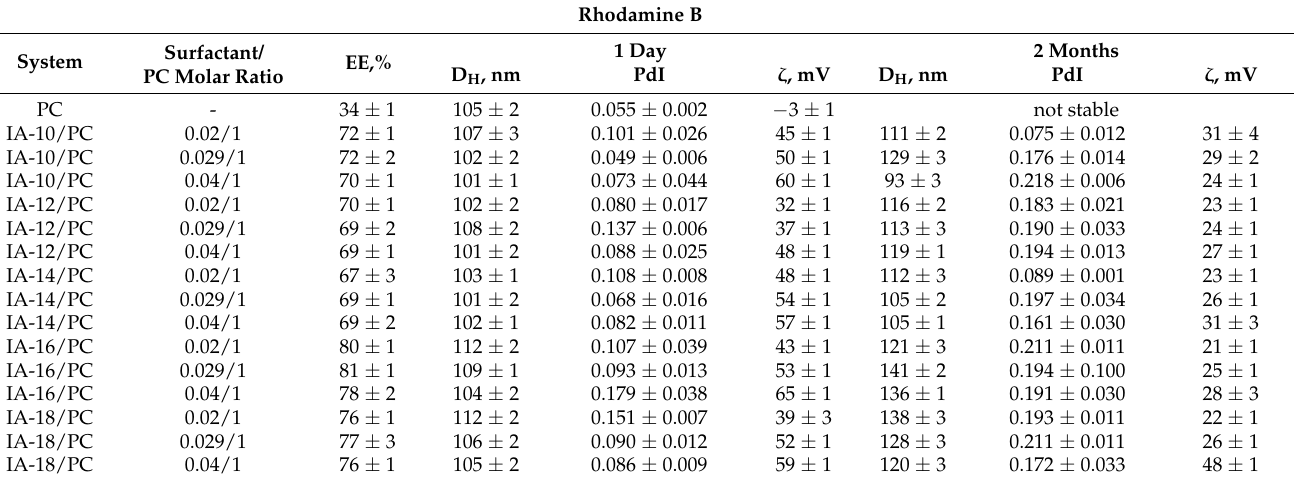
Table 2. Physicochemical characteristics of liposomes based on PC modified by IA-n loaded with rhodamine B at various surfactant/lipid molar ratios, IA-n hydrocarbon tail lengths, and storage times: encapsulation efficiency (EE, %), hydrodynamic diameter (D H , nm), polydispersity index (PdI), and zeta potential ( ζ , mV), 25 ◦ C.